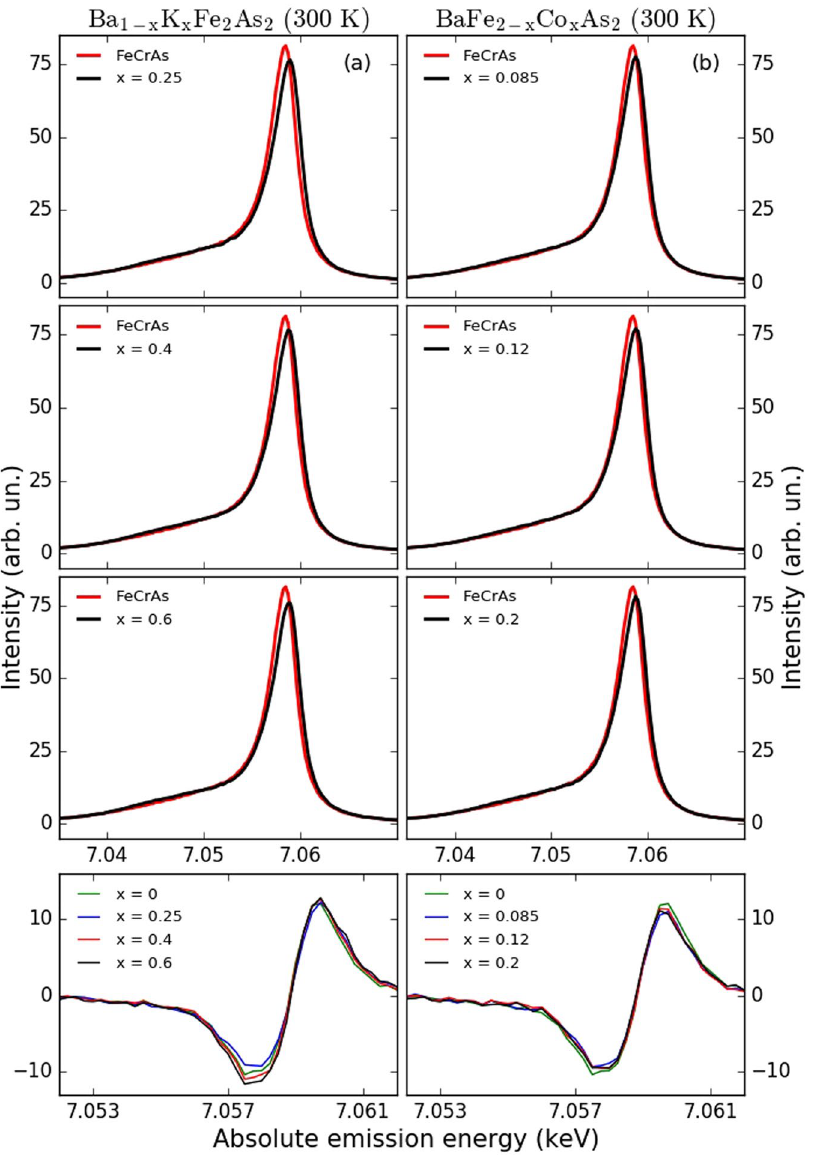
Figure 3. K β XES at 300 K for Ba 1 − x K x Fe 2 As 2 ( a ) with x = 0.25, 0.4, and 0.6 and Ba 1 − x K x Fe 2 As 2 ( b ) with x = 0.085, 012, and 0.2 at 300 K. The last row is indicating the relative difference spectra for Ba 1 − x K x Fe 2 As 2 and Ba 1 − x K x Fe 2 As 2